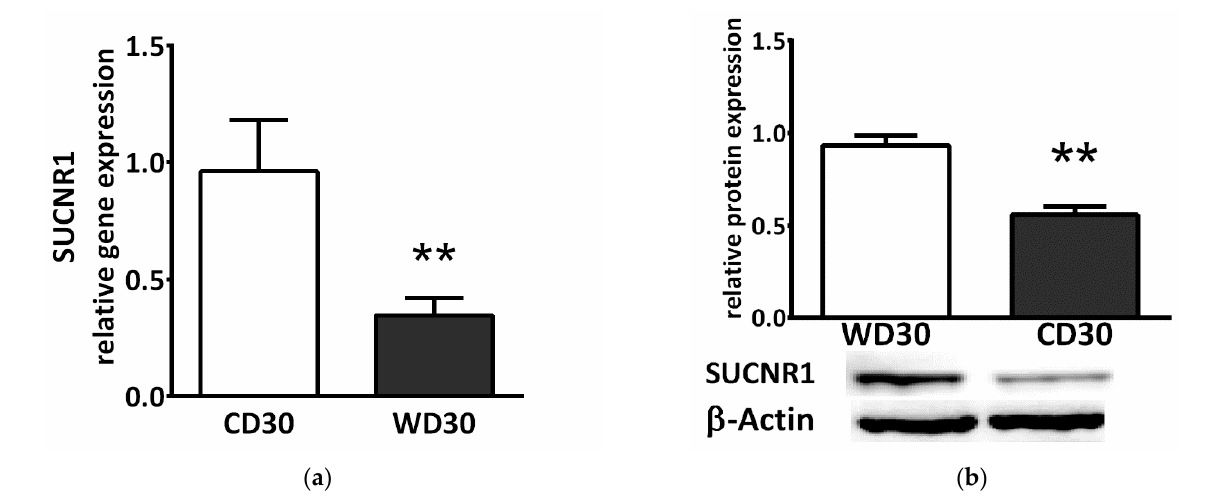
Figure 9. SUCNR1 expression in mice fed a control diet (CD30) or a Western-style diet (WD30) for 30 weeks. ( a ) Relative gene and ( b ) protein expression. Results are expressed as the means ± SD; ** p < 0.01 (n = 6 each group).